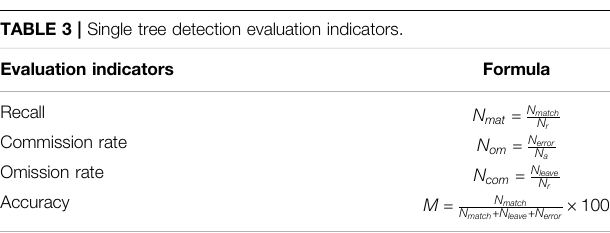
TABLE 3 | Single tree detection evaluation